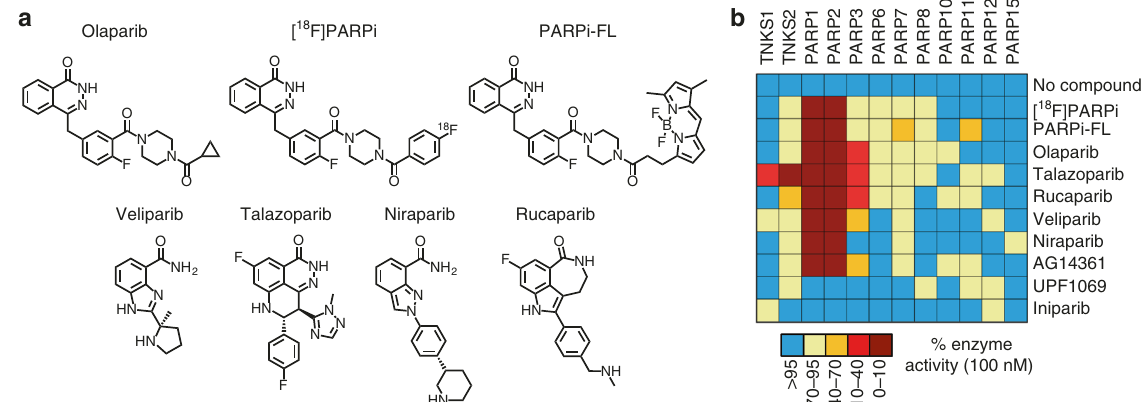
Fig. 1 Properties of PARP inhibitors. a Structures of 5 clinical therapeutic PARP inhibitors and the 2 PARP imaging agents. b Heatmap visualizing enzymatic activity screening of 10 small molecules against 12 PARP enzymes at 100 nM concentration (for additional concentrations, see Supplementary Fig.